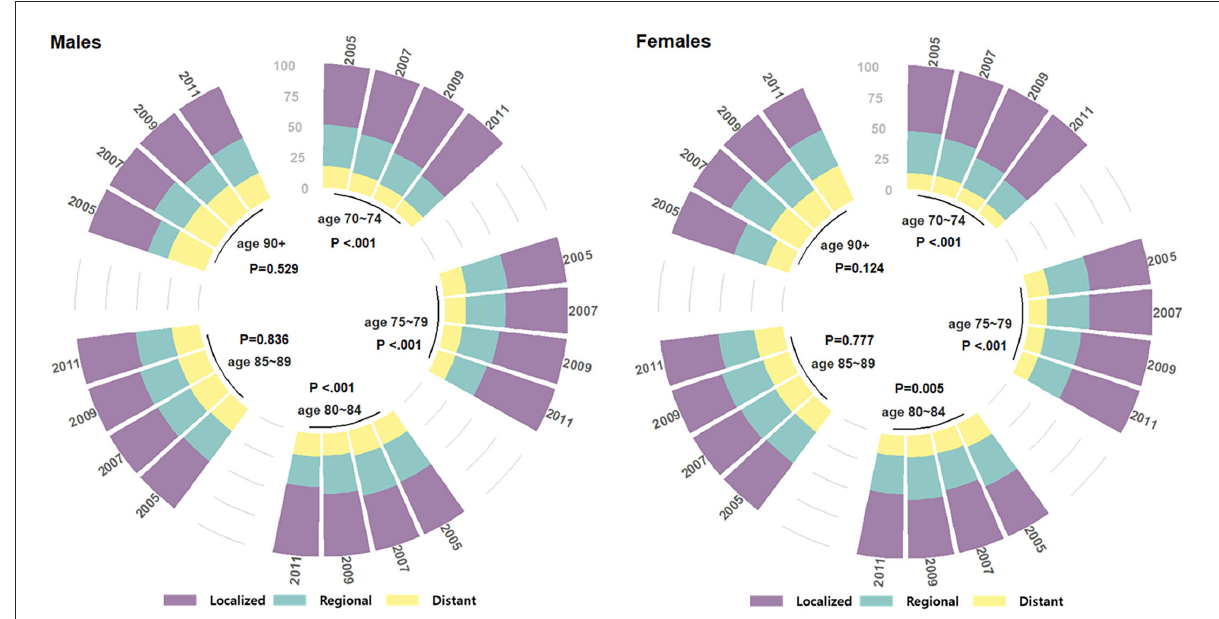
FIGURE1 SEER stage distributions over the four time periods of gastric cancer diagnosis in 2005–2012, among older (age at Dx 70 cancer in Korea.